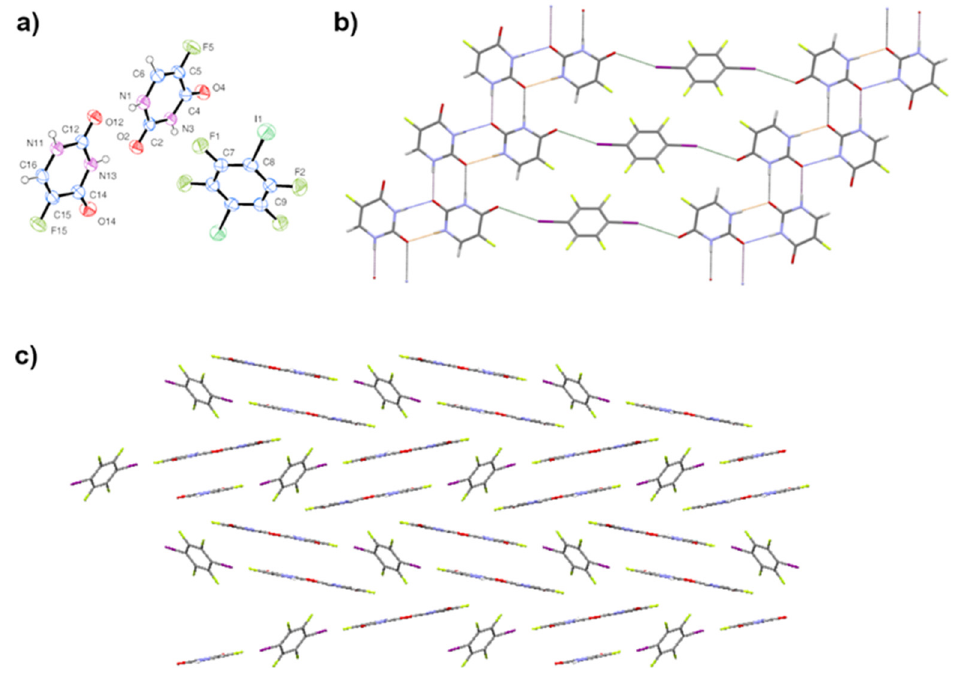
Figure 4. ( a ) ORTEP representation showing the cocrystal 3 with atom labeling. ( b ) Belts formed by 5-fluorouracil–TFDIB molecules through H-bond and X-bond interactions. ( c ) 3D structure in co- crystal 3